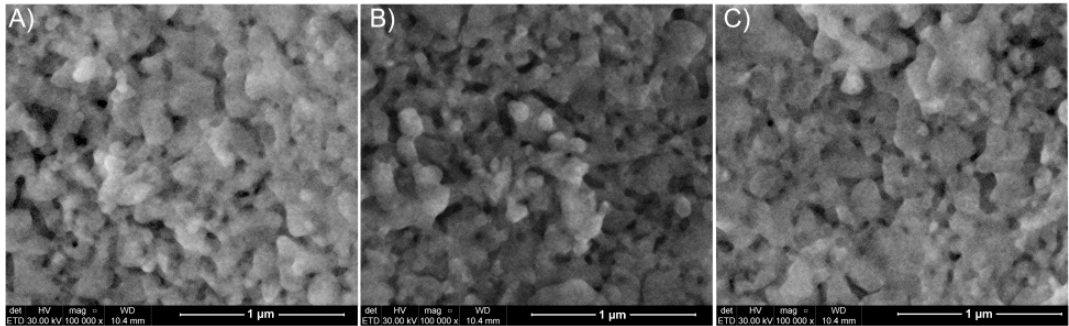
Figure 2. SEM images of Ag:HAp ( A ); T-Ag:HAp ( B ) and C-Ag:HAp ( C ) thin films.